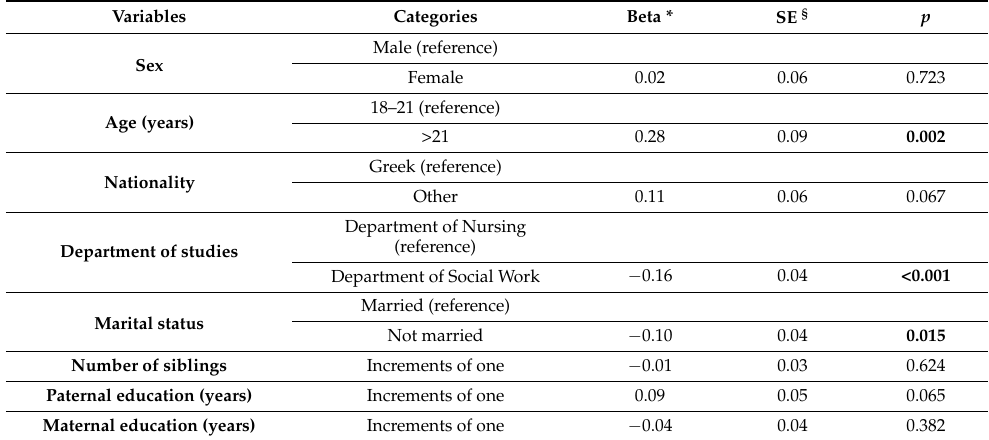
Table 4. Multivariate linear regression analysis of log-transformed knowledge scores about HPV per se, in association with sociodemographic features. Bold cells denote statistically significant associations.